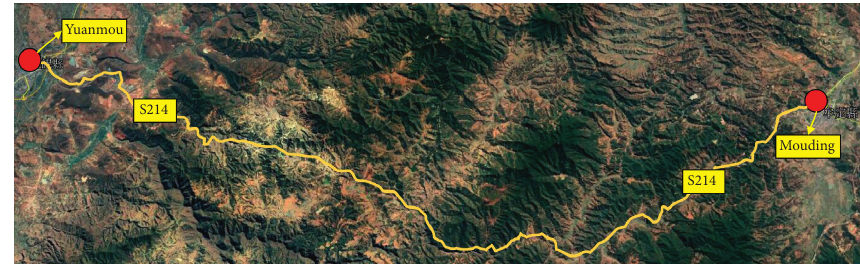
Figure 2: The location of the two-lane rural road.